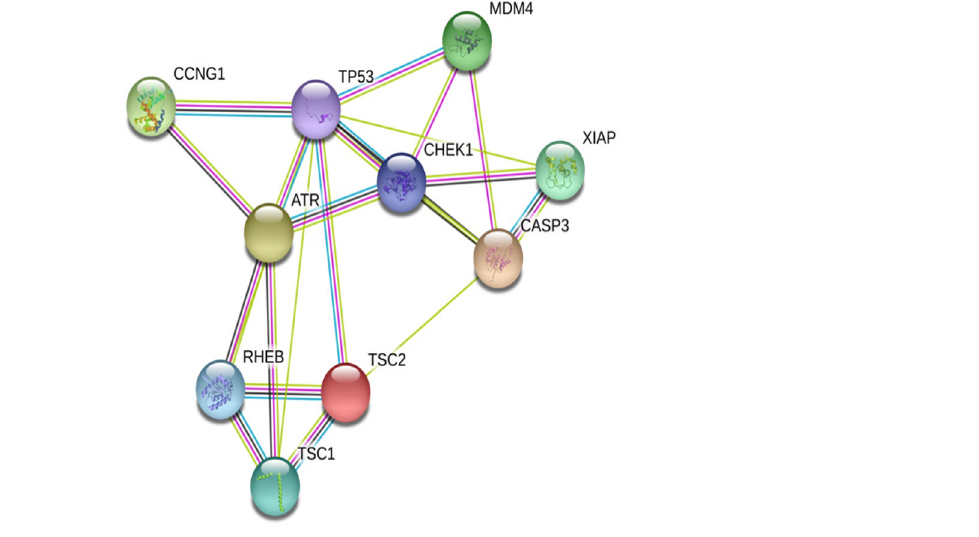
Figure 2. Protein–protein interaction (PPI) network for upregulated DEGs in p53 pathway. Nodes represent proteins and lines represent interactions of proteins in networks.